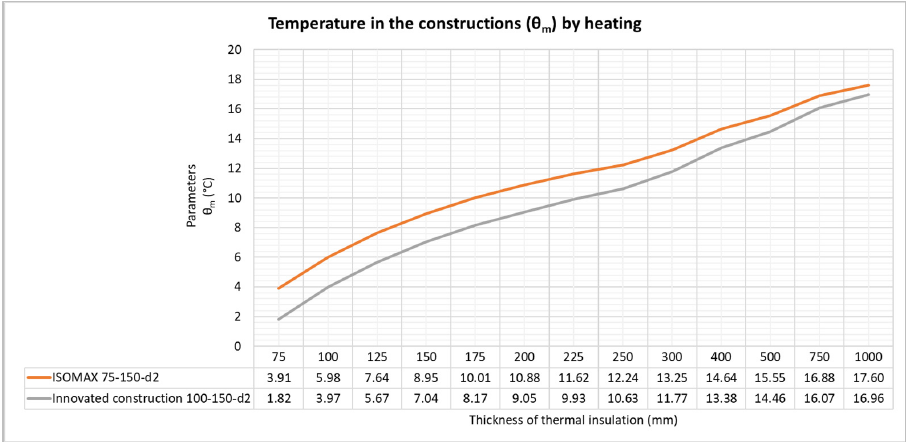
Figure 23. Dependence of the average temperature θ m in the thermal barrier layer of the ISOMAX panel and the innovative panel in the heating period on the thickness of the external thermal insu- lation.